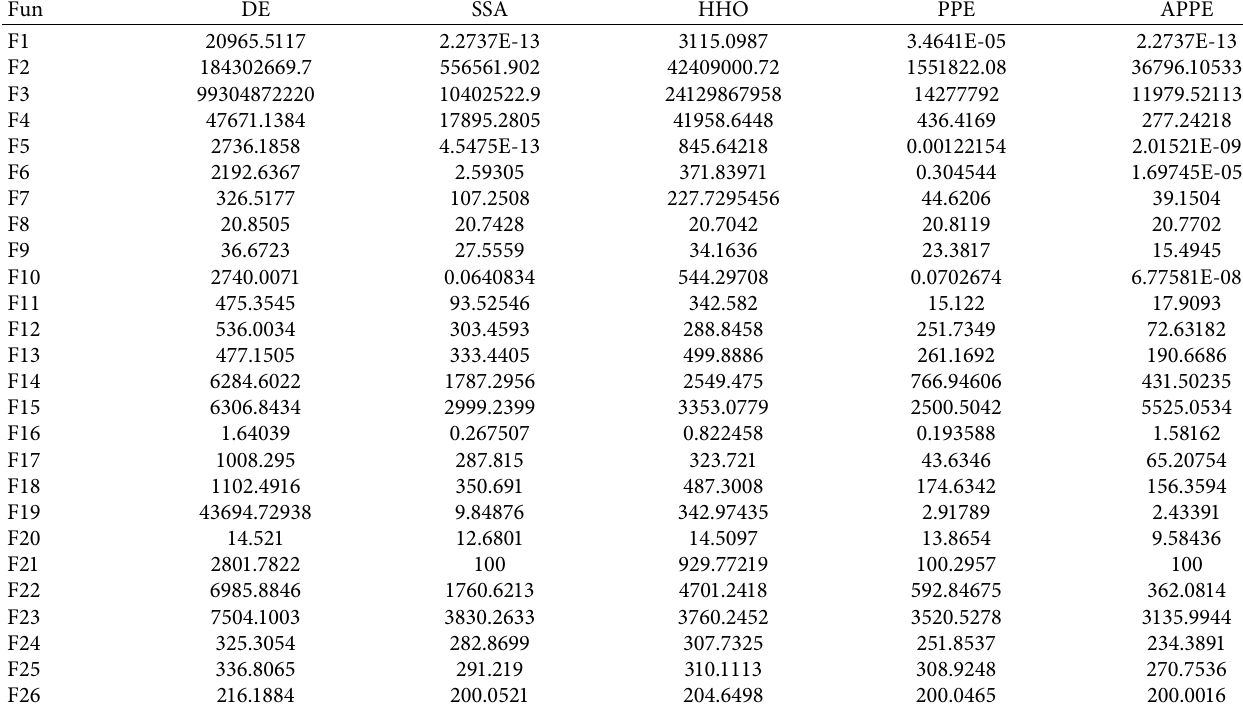
Table 6: Comparison of the best result of 51 runs on 30D in 28 benchmark